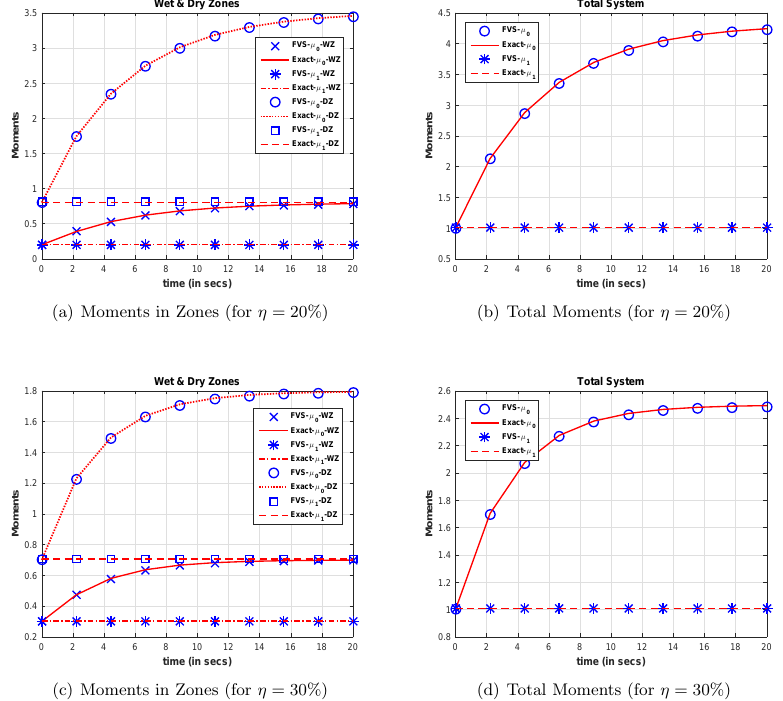
Figure 3. Different order moments and number density for the additive kernel. FVS, Finite Figure 3: Different order moments for sum kernel using various values of η . Volume Scheme. Table 1. Quantitative relative errors in the zeroth and first order moments for the additive kernel. Table 1: Qunatitative relative errors in zeroth and first order moments for sum kernel Moments